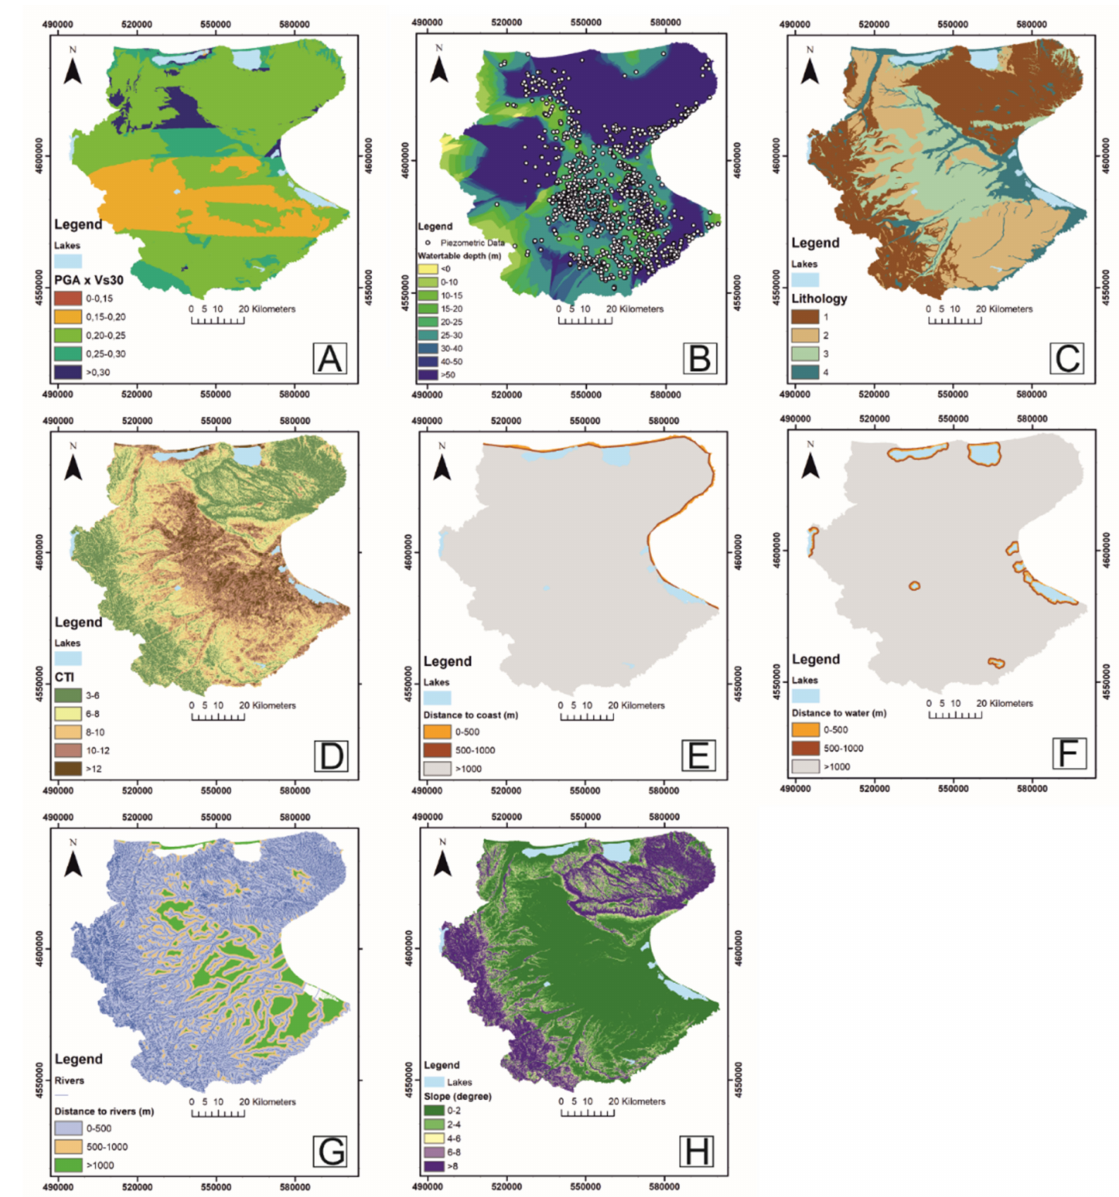
Figure 4. Geospatial predictors selected for the susceptibility analysis. ( A ) PGAxVs 30 ; ( B ) Water table depth; ( C ) Lithological map, classes are the following: 1: carbonates of the Gargano Promontory and the flysch units of the Daunia Apennines; 2: units with a prevalent ruditic, silty-sandy, and/or arenitic component; 3: loose deposits with a predominantly sandy-gravelly component; 4: loose deposits with prevalent pelitic components or alluvial deposits with a prevalent gravelly-sandy component; ( D ) Compound Topographic Index (CTI); ( E ) Distance to coast; ( F ) Distance to lakes; ( G ) Distance to rivers and streams; ( H )